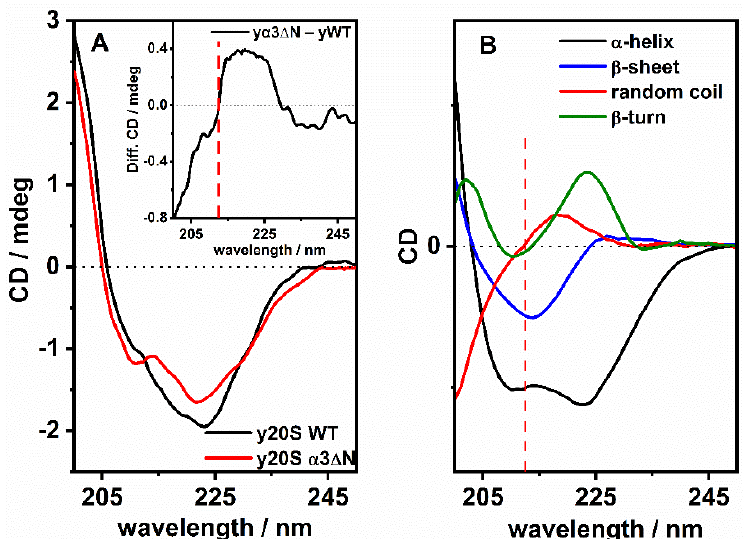
Figure 2. ( A ) Comparison between ECD spectra of y20S WT 25 nM, in 150 mM Tris buffer with 100 mM of NaCl at pH 7.6 (black trace) and y20S α 3 ∆ N mutant in the same buffer (red trace). Inset: ECD difference between the spectra of α 3 ∆ N minus that of WT. ( B ) ECD spectra of canonical confor- mations of polypeptides. From here after, the red dotted line indicates the cross-over wavelength (the point where ECD change sign) of the ECD signal for random coil.